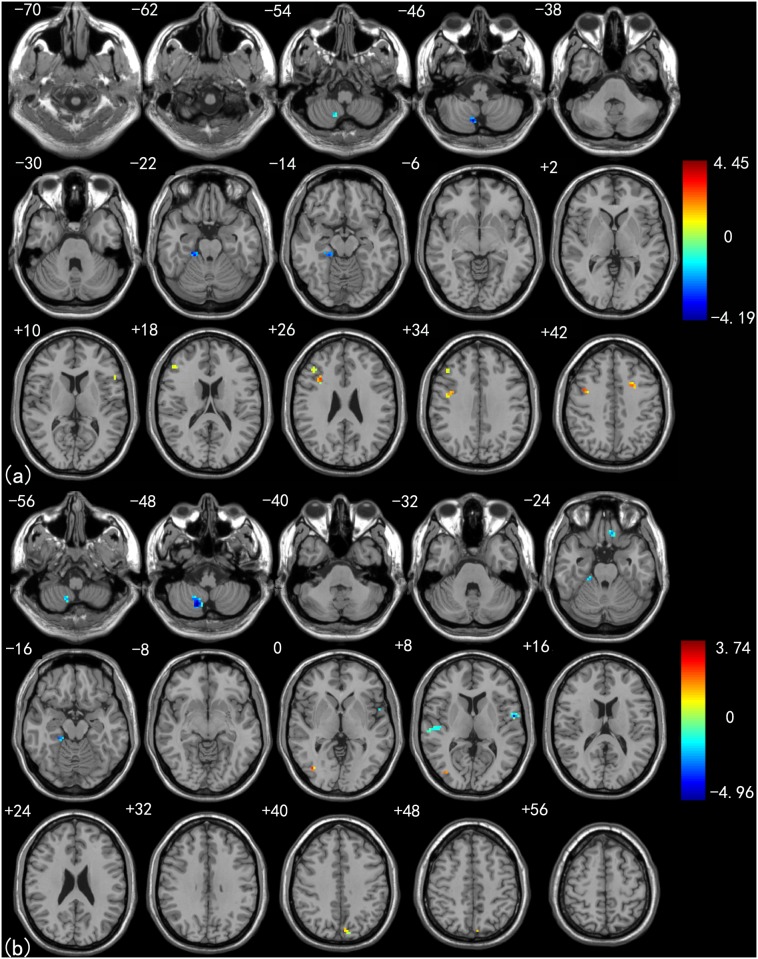
Left (a) and right (b) thalamus connectivity difference maps between LMCI patients and healthy control group (P < 0.01, 40 voxels, Alphasim corrected).